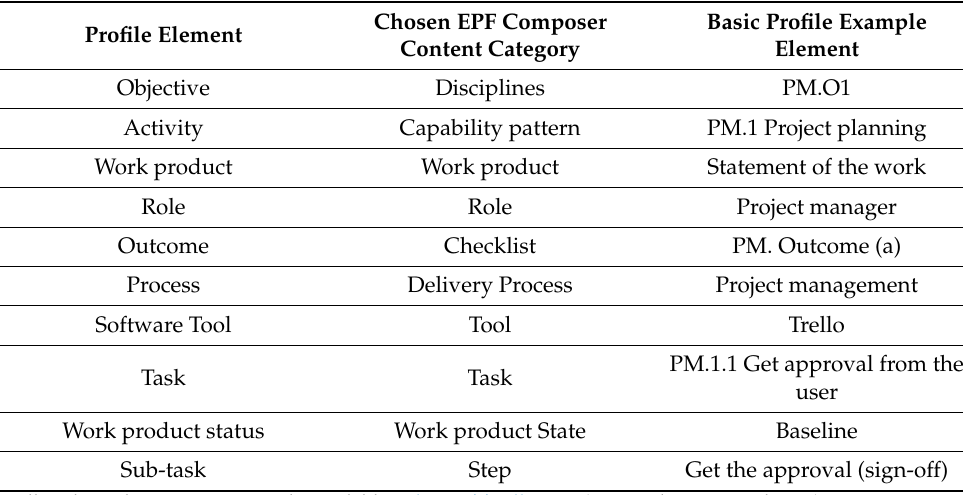
Work product status Work product State Baseline